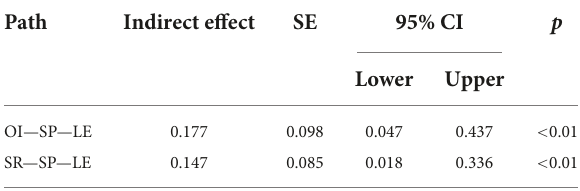
significantly predicted learning engagement. So hypothesis 3a was